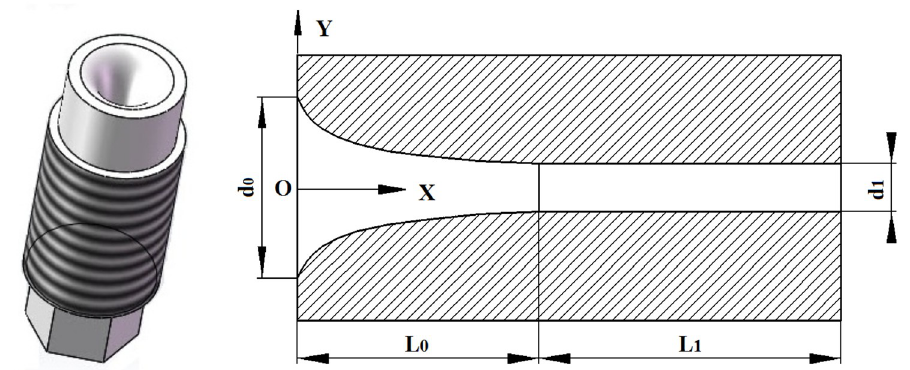
Fig 3. The nozzle section and coordinate